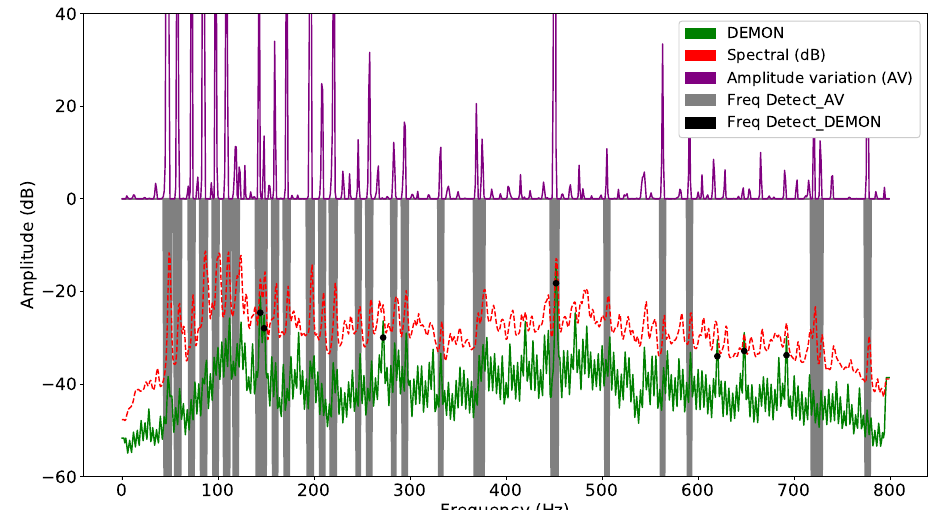
Figure 6. Signal frequency detection by DEMON-AV with Record-2.